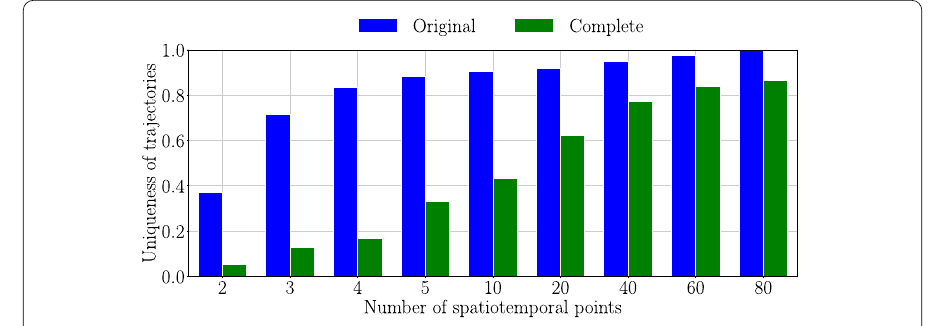
Figure 10 Revisited results from [5]. Ratio of trajectories with uniqueness | U | = 1 for a number of spatiotemporal points in the abscissa, for original (left) and complete (right)